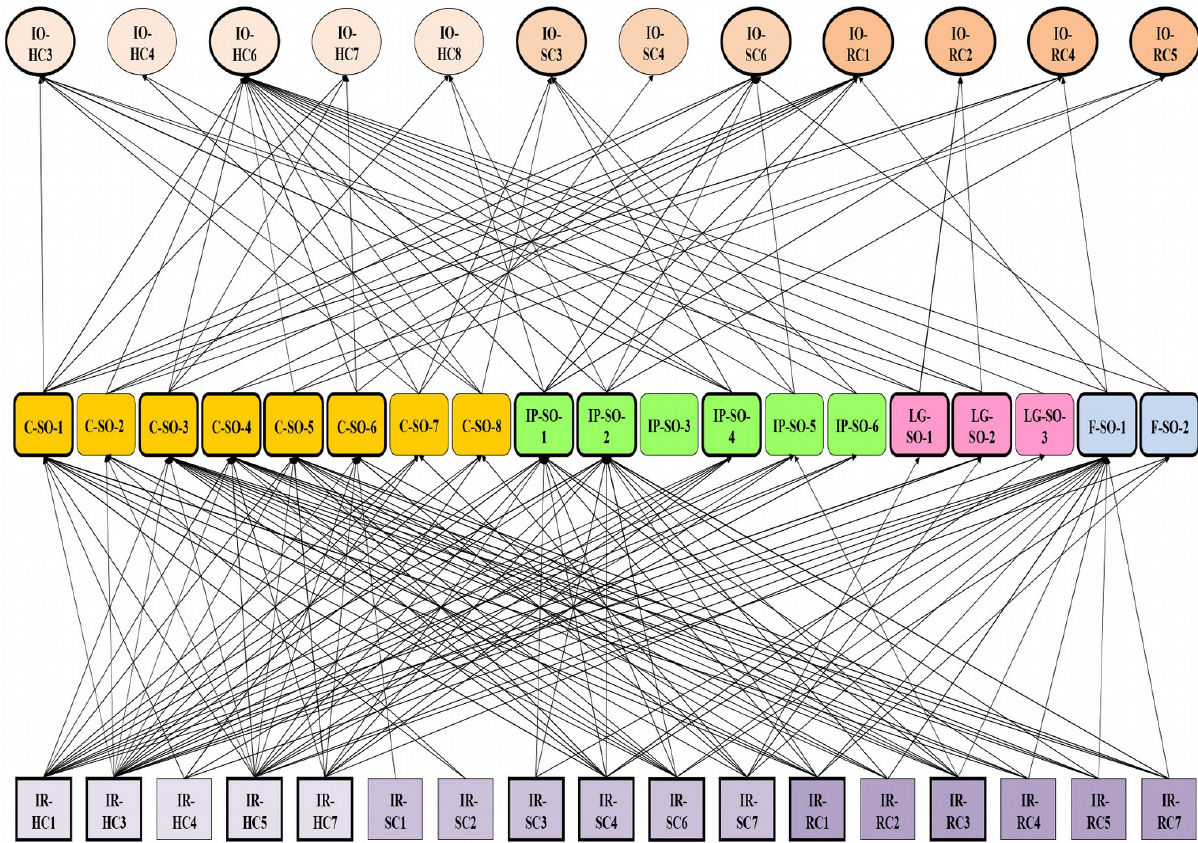
Figure 1. Graphic of global deployment of the intangible assets (Boj et al.,